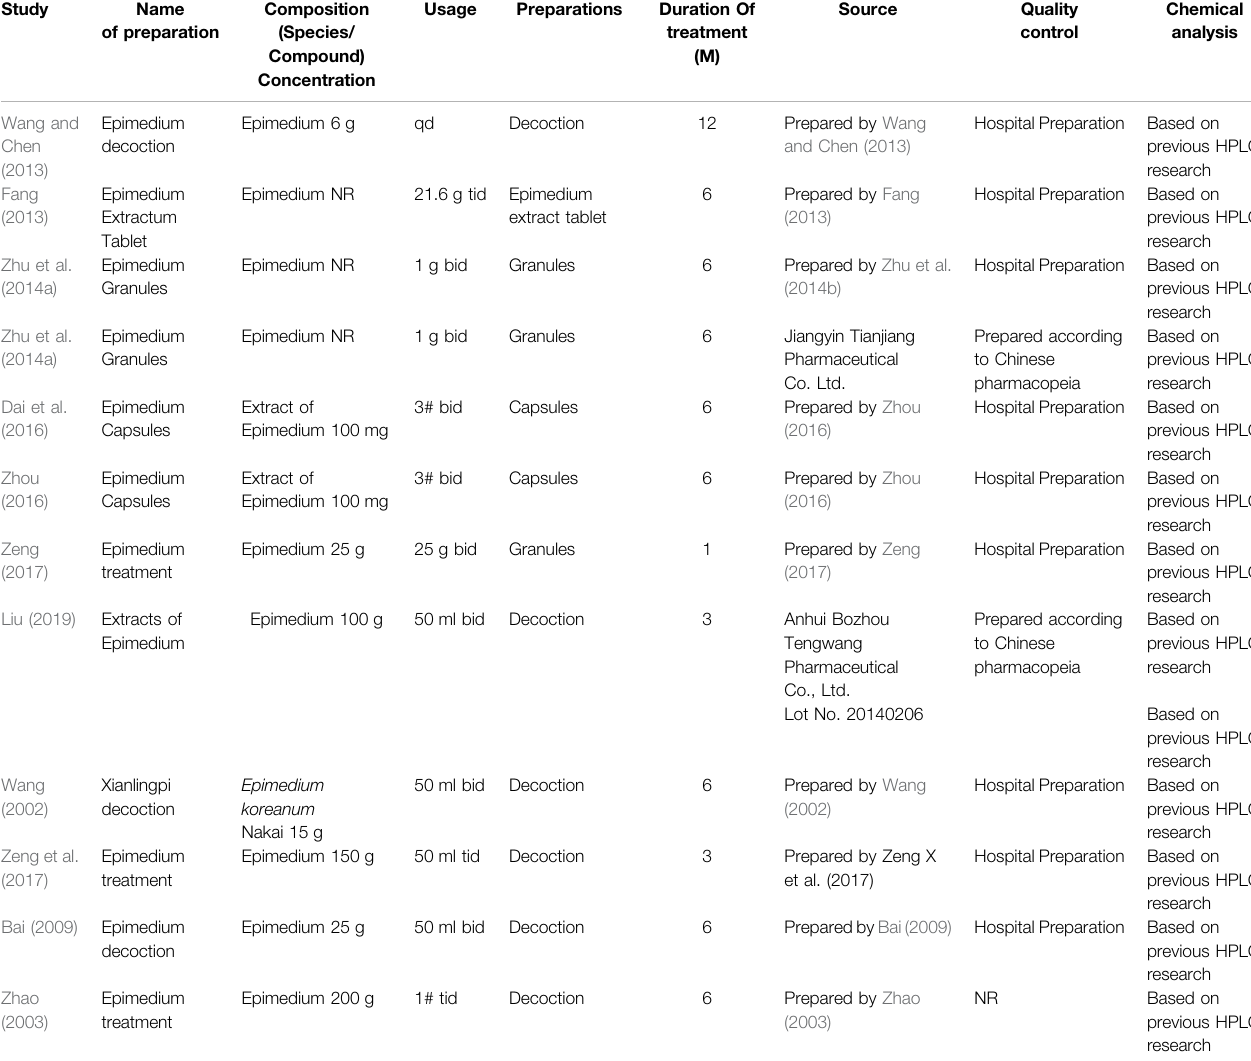
TABLE 3 | Compositions, concentration, usage, source, and quality control of Epimedium